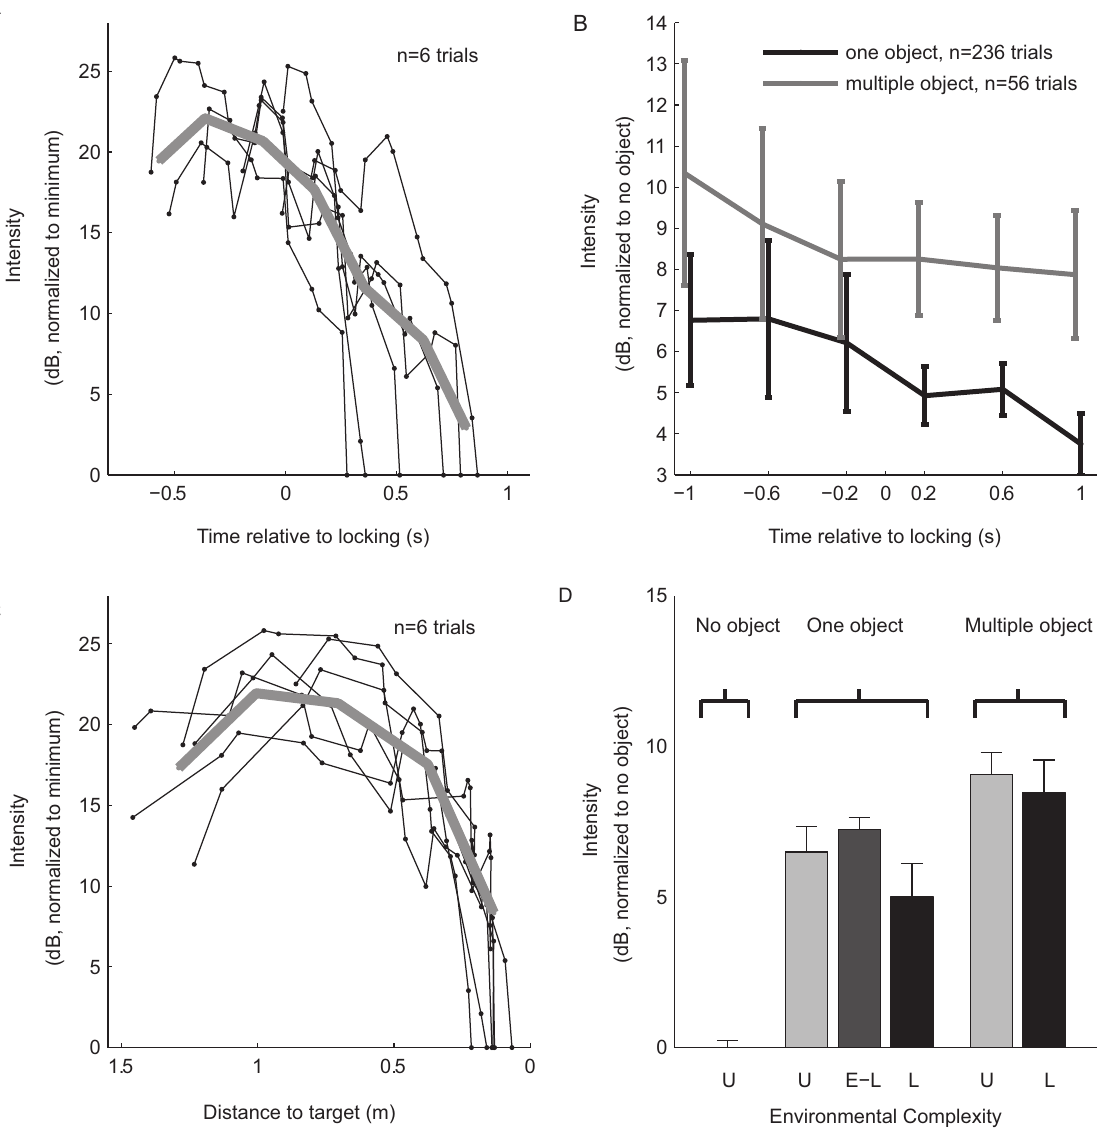
Figure 3. Lingual echolocators modify the intensity of their emissions according to the environmental complexity and the stage of target approach. (A) Examples of six trials, showing that emission intensity gradually decreases with time along the approach. Average is depicted by thick gray line. (B) Population average intensity plotted as function of time relative to locking, for the one-object and multiple-object setups. Error bars, mean 6 s.e.m. The two curves were shifted by 30 ms relative to each other, for display purposes only. (C) Examples of the same six trials as in (A), with intensity plotted as function of distance to target. Average is depicted by thick gray line. Note decrease in intensity that began 80–100 cm before landing. (D) Click intensity increased with the environmental complexity. Intensity was not lower when the bats were locked on the target before the final locking (dark gray bar marked E-L).